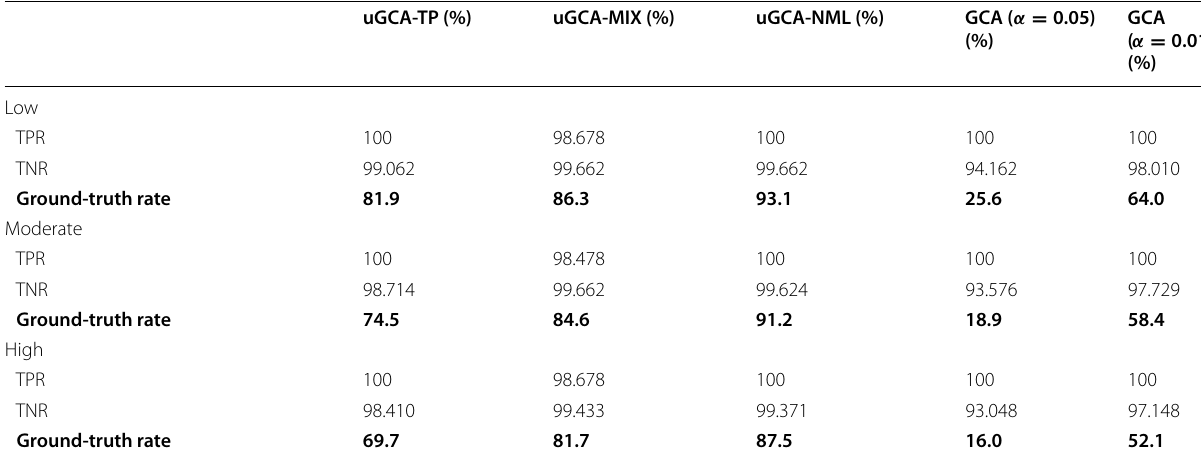
Table. 1 Comparison between uGCA methods and conventional GCA under different noise level